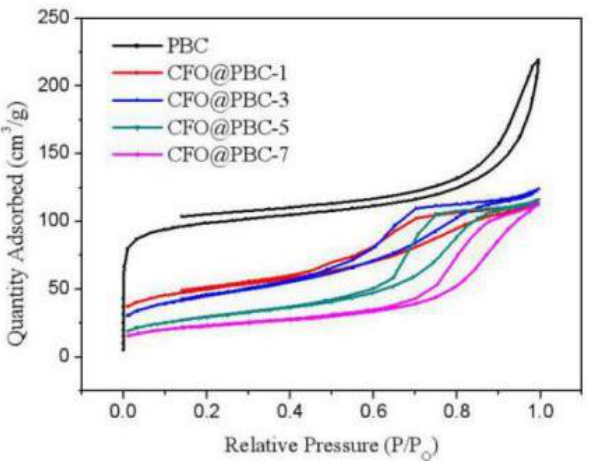
Figure 4. Nitrogen adsorption – desorption isotherm of the PBC and CFO@PBC samples.